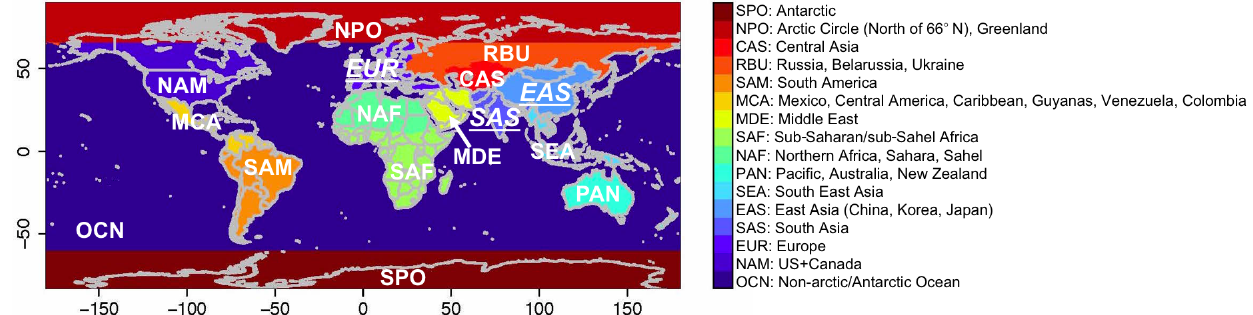
Figure 1. Definitions of the 16 source regions used in the HTAP2 SR relationship study (more details in Koffi et al., 2016). The map is plotted based on data on a 0.1 ◦ × 0.1 ◦ resolution grid. We focus in this study on the impact of anthropogenic pollution from selected non-North American source regions (i.e., EAS, SAS, and EUR), whose names are underlined and in